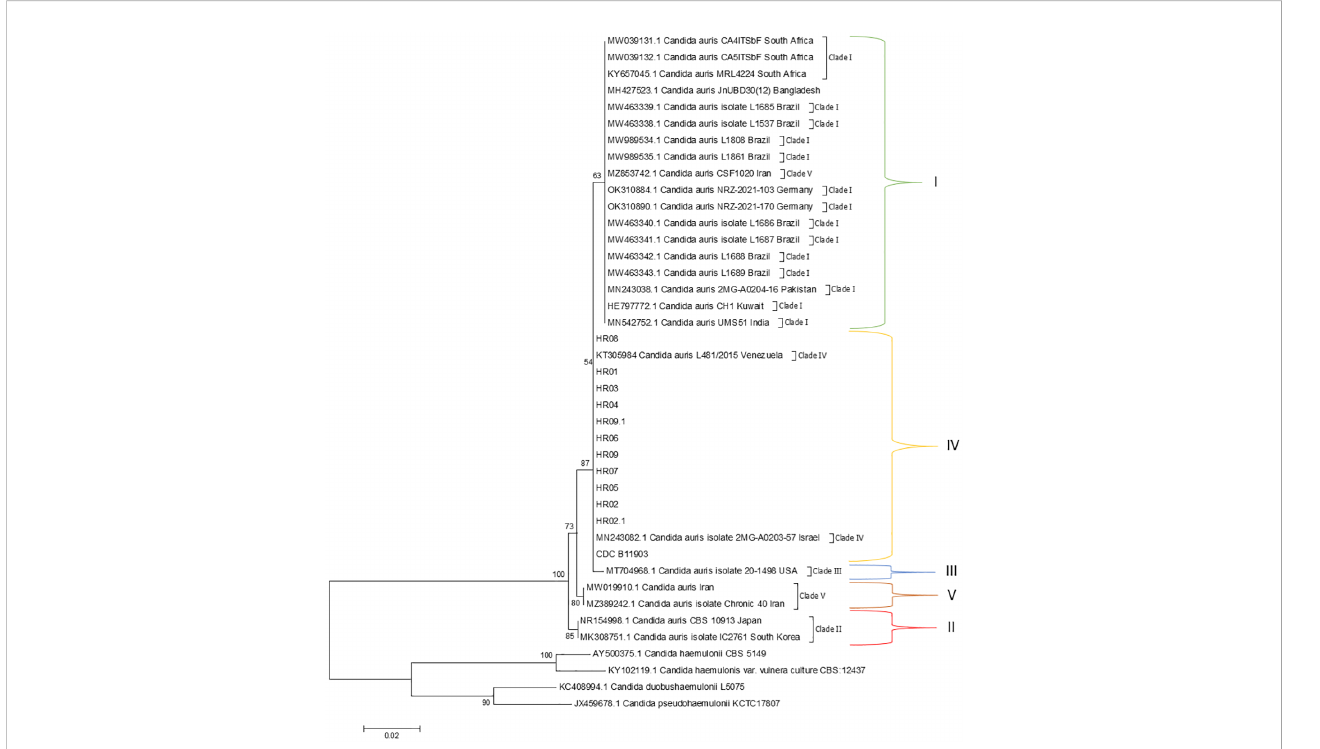
FIGURE 2 Evolutionary relationships of taxa. Phylogenetic tree generated by neighbor-joining, maximum likelihood, and maximum parsimony analysis using partial nucleotide sequences of ITS. Bootstrap values (1,000 replicates) were added to the respective branches. All species are indicated at its respective position at the phylogenetic tree. Evolutionary relationships involved fi ve taxa and the analysis of 19 nucleotide sequences by six C. auris strains of previous studies used as a reference to each clade reported in this species, in which sequences were obtained from GenBank. There were a total of 250 positions in the fi nal dataset. Evolutionary analyses were performed in MEGA6 (Tamura et al., 2013).